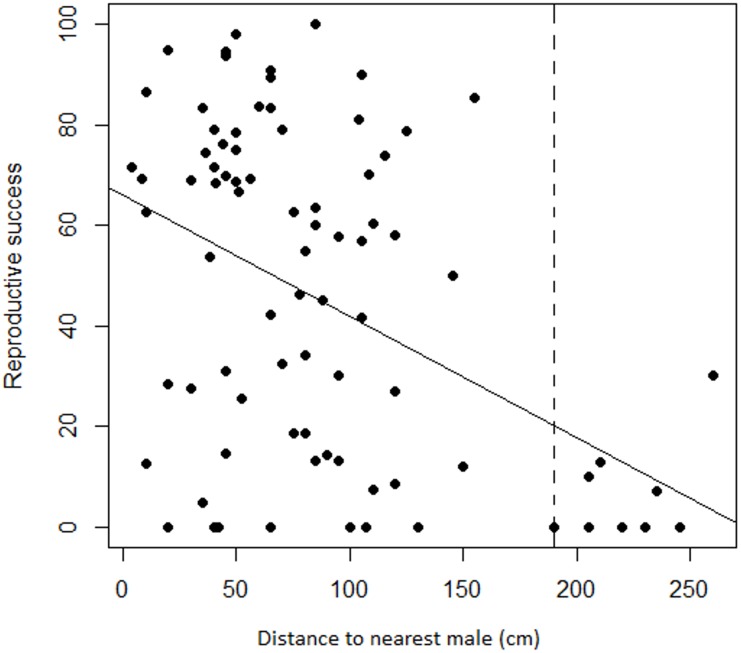
Relationship between female reproductive success and distance to the nearest male in Z. portoricensis.Linear regression: \documentclass[12pt]{minimal}
\usepackage{amsmath}
\usepackage{wasysym}
\usepackage{amsfonts}
\usepackage{amssymb}
\usepackage{amsbsy}
\usepackage{upgreek}
\usepackage{mathrsfs}
\setlength{\oddsidemargin}{-69pt}
\begin{document}
}{}${r}_{adj}^{2}=0.18$\end{document}radj2=0.18, F1,83 = 19.78, P < 0.001. The dashed line represents a threshold distance (i.e., 190 cm) after which the negative relationship between reproductive success and distance becomes significantly different from zero.